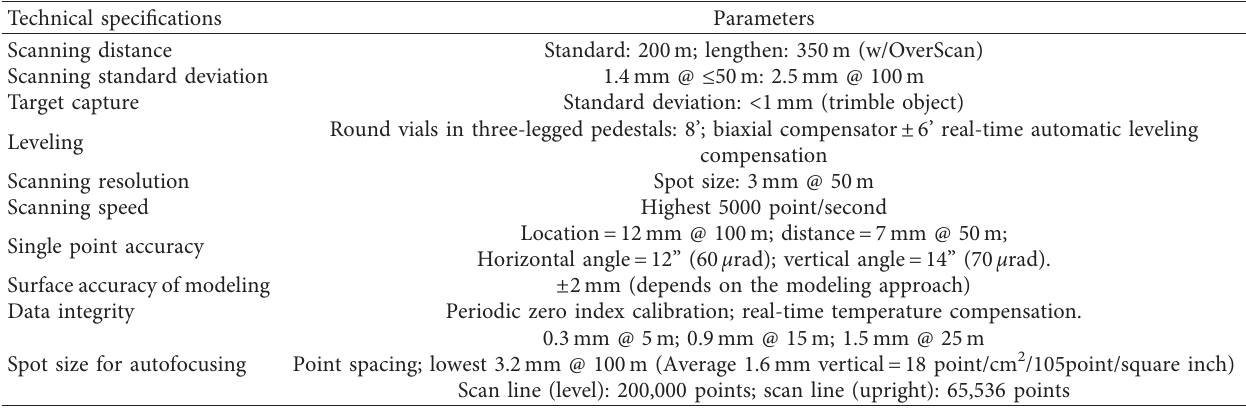
Table 1: Trimble GX200 technical specifications.